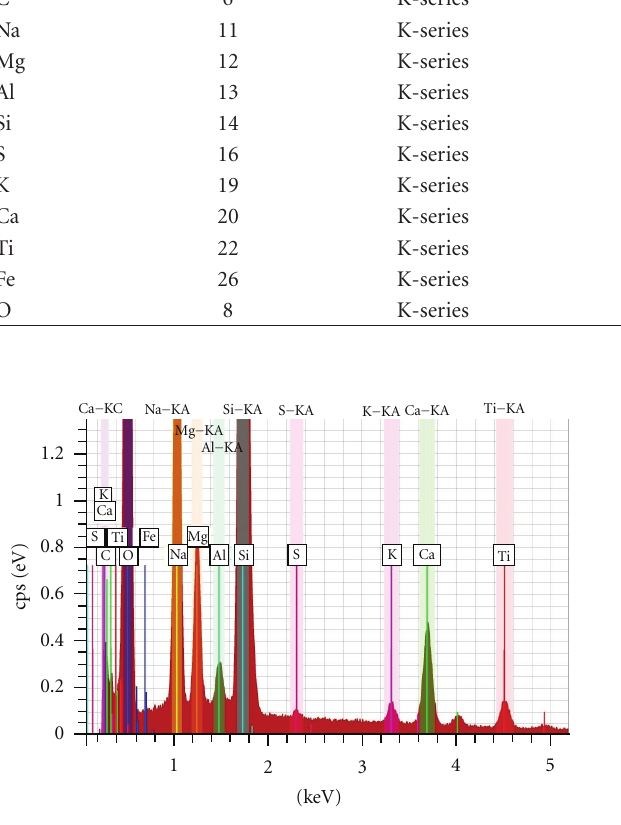
Figure 4: EDX spectrum of the TiO 2 :(Fe, S), Sample